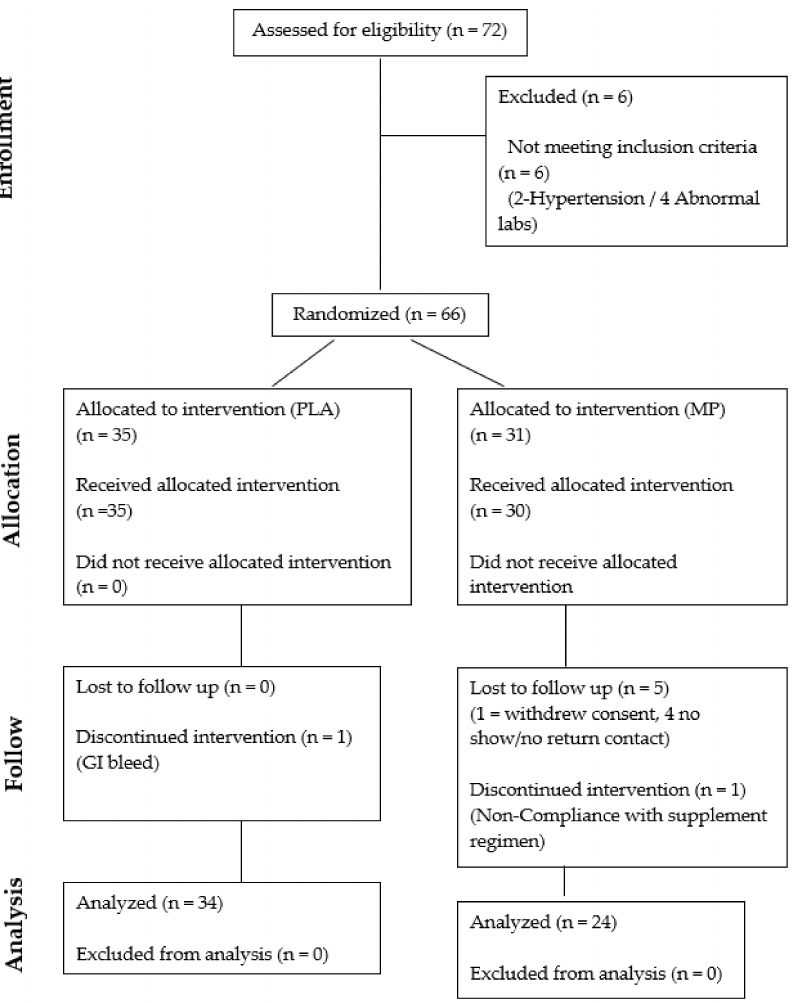
Figure 1. Consolidated Standards of Reporting Trials (CONSORT)